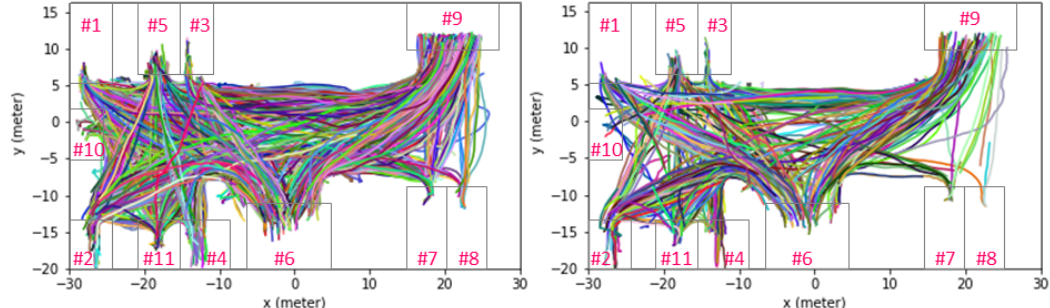
Figure 2. Visualization of tracklets of training and testing data: ( left ) all tracklets of training data; ( right ) all tracklets of testing data. Numbers shown in magenta are indexes of